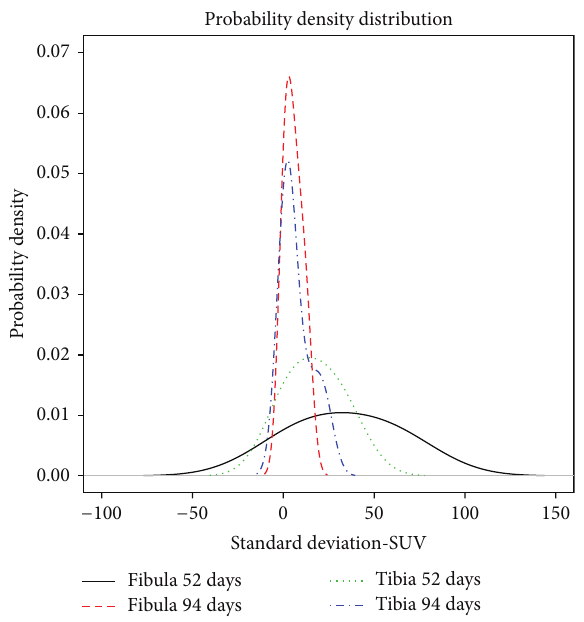
Figure 6: The probability density plot showing the density dis- tribution of SUV data for Patient 4. The second tibia distribution shows that the data may consist of two density distributions as was suspected from the clinical